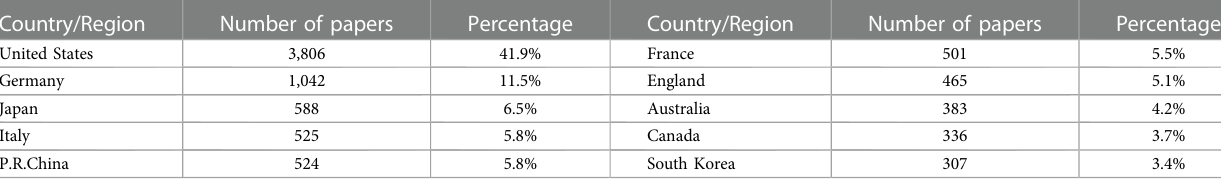
TABLE 2 Distribution of Top 10 source countries/regions of ECMO research papers.